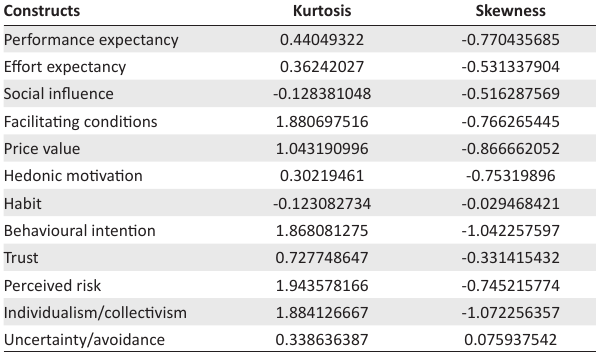
TABLE 3: Skewness and kurtosis